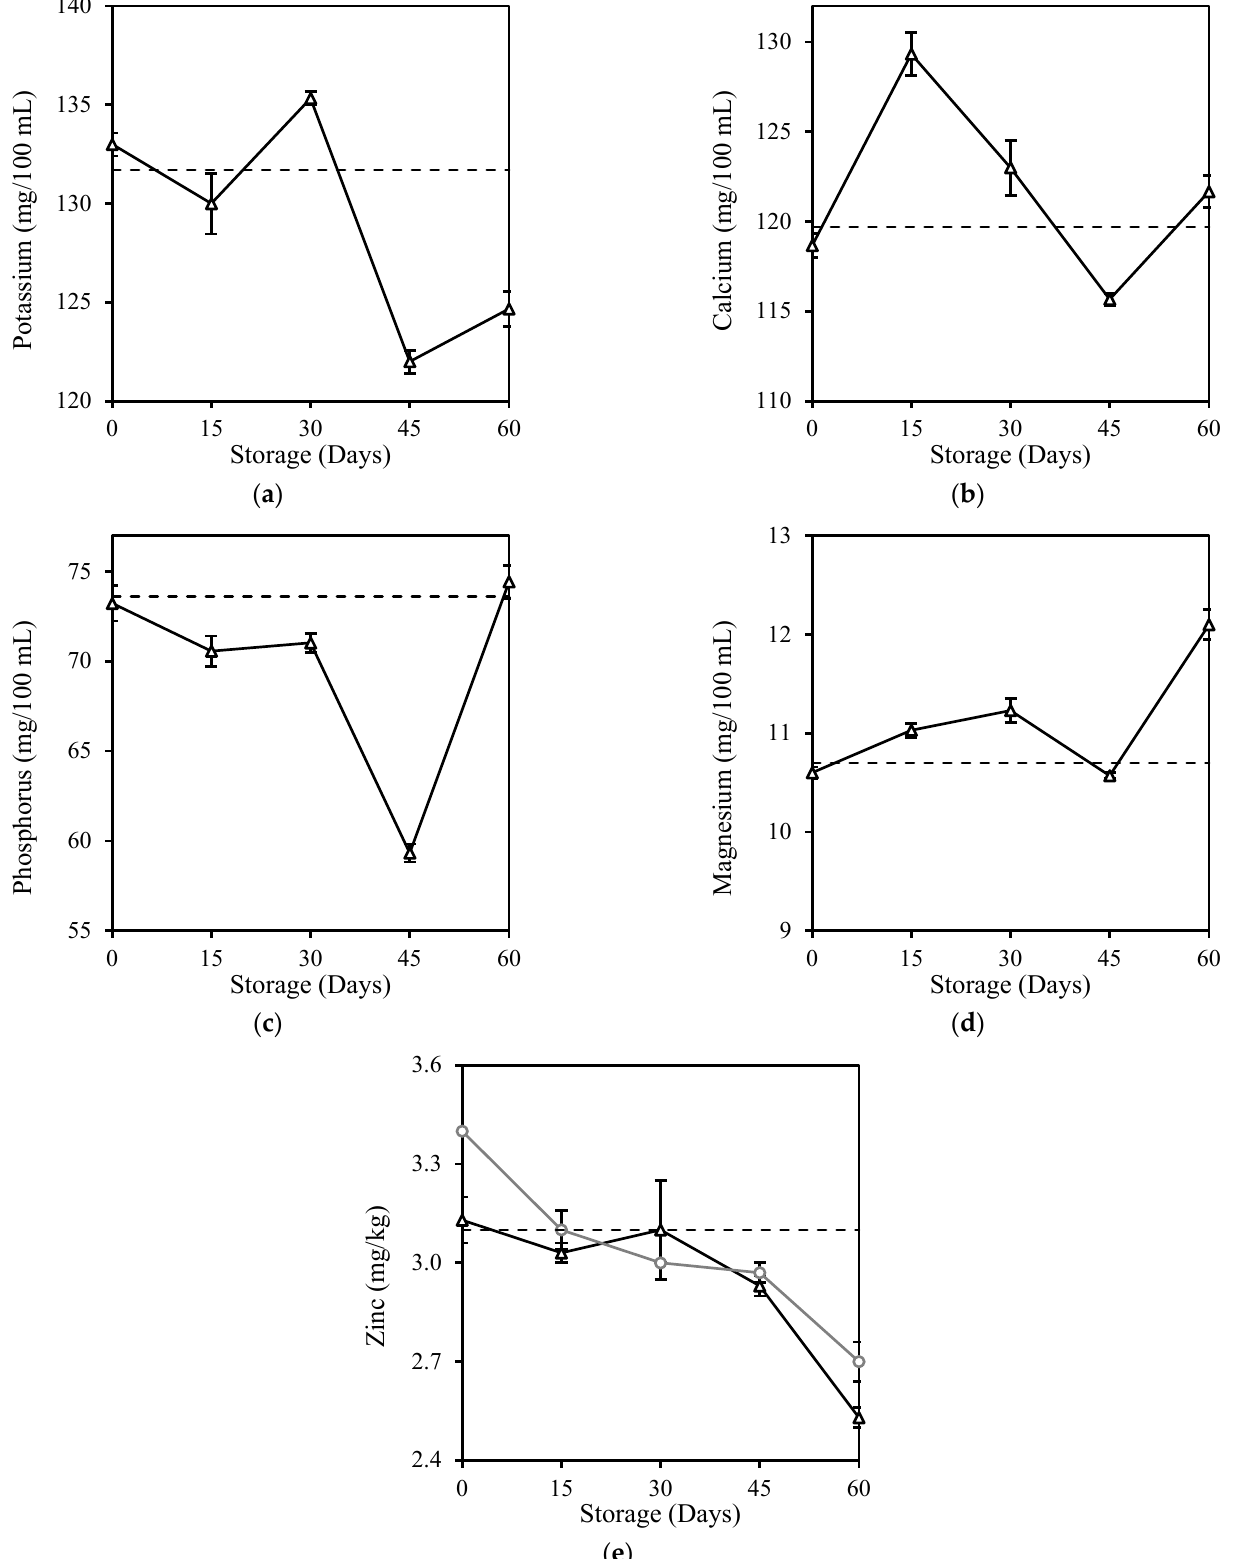
Figure 5. Changes in ( a ) Potassium, ( b ) Calcium, ( c ) Phosphorus, ( d ) Magnesium, and ( e ) Zinc contents of HPP and ESL milk during 60-day storage. Dotted lines represent the fresh milk before treatment.